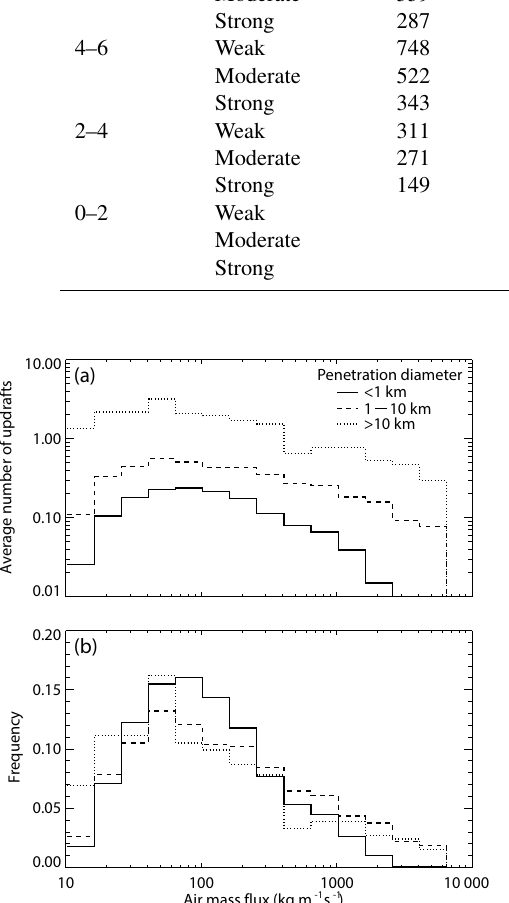
Figure 6. (a) Average number and (b) occurrence frequency of up- drafts as a function of air mass flux observed in penetrations with length < 1km (solid), 1–10km (dashed), and > 10km (dotted). The result is a composite of HiCu, COPE, and